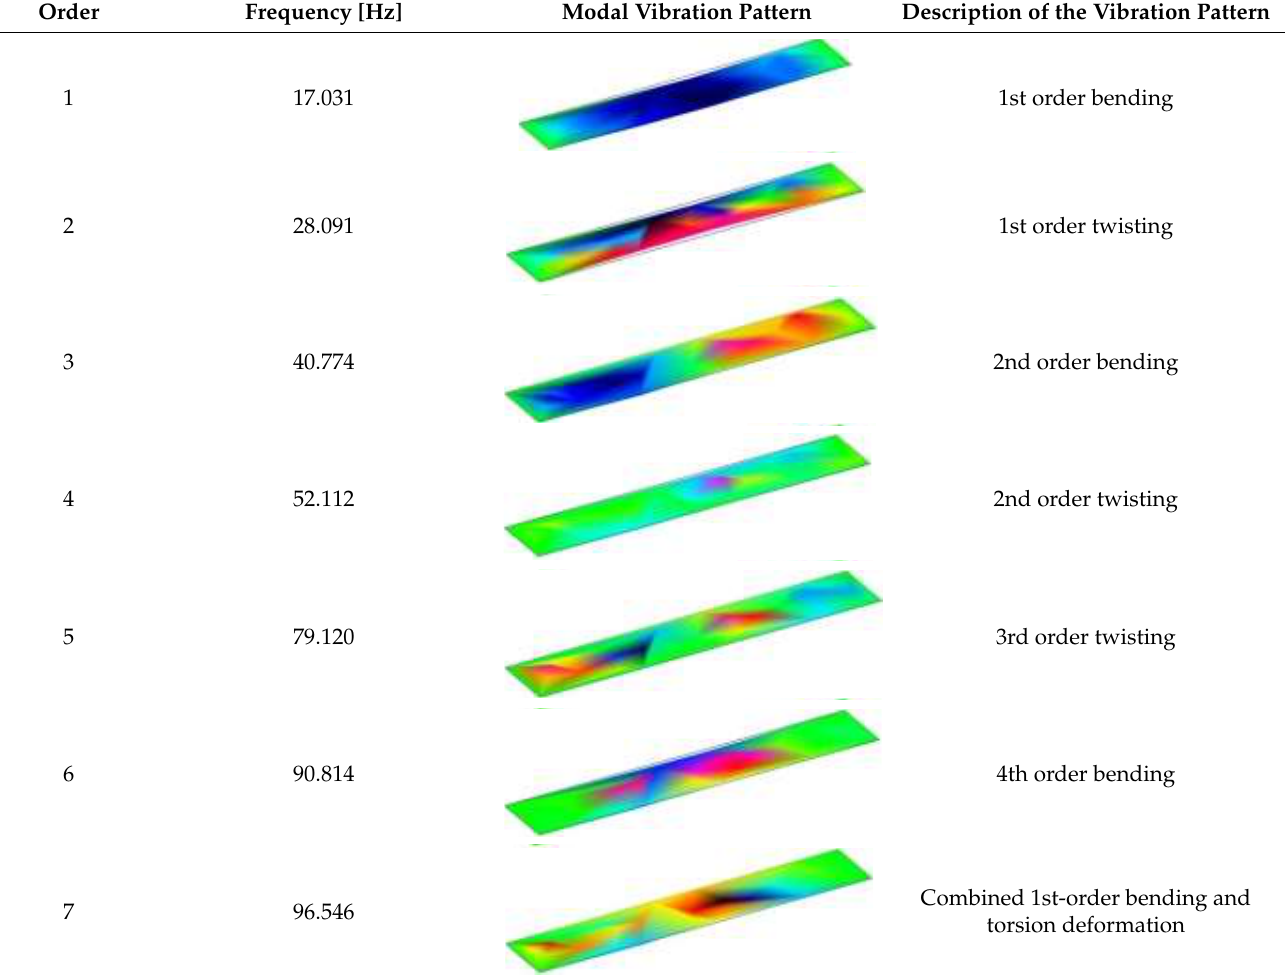
Table 9. Modal frequency and vibration pattern of the bridge deck based on the IPSOARW distri- bution method.